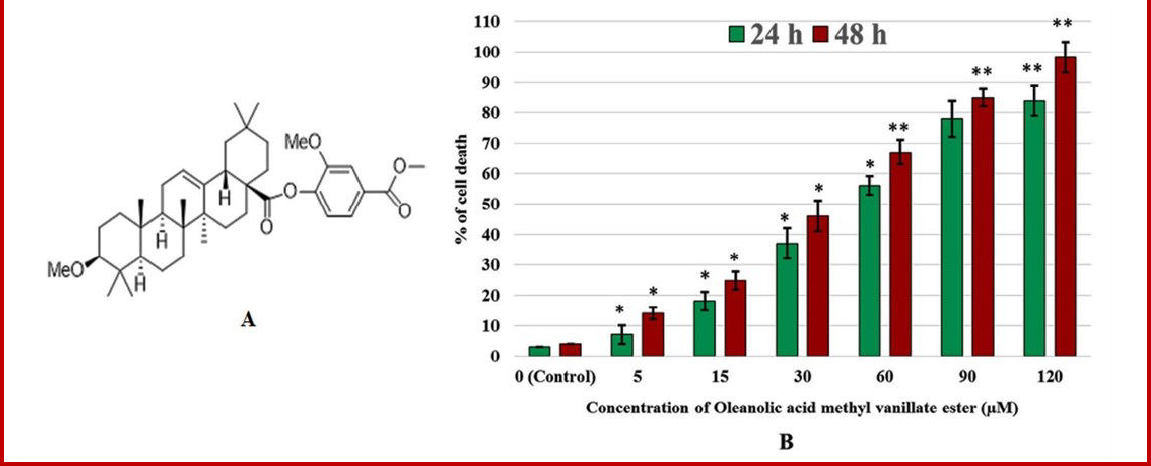
Figure 1: (A) Chemical structure of oleanolic acid methyl vanillate ester (OAMVE); (B) Cytotoxic effect of OAMVE in human cervical cancer cells (HeLa); Data are shown as the mean ± SD of three independent experiments; *p<0.05; **p<0.01, vs 0 µM